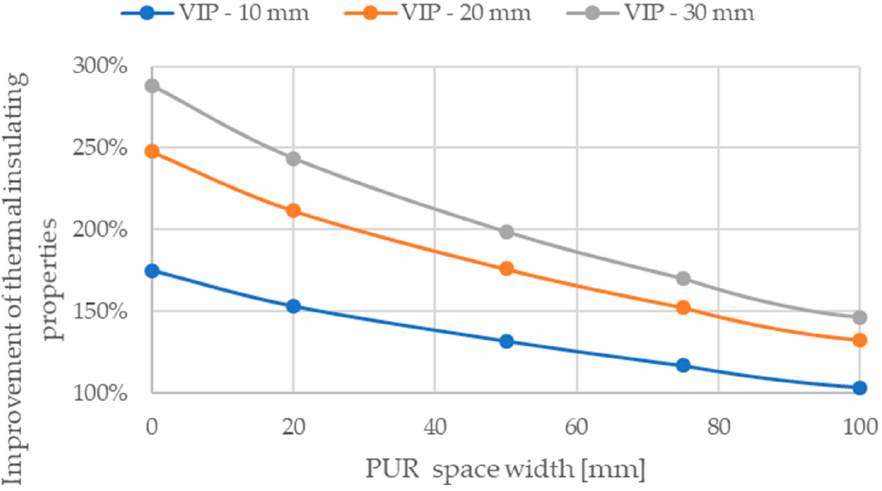
Figure 8. Dependence of thermal resistance increase of panels on PUR space width.